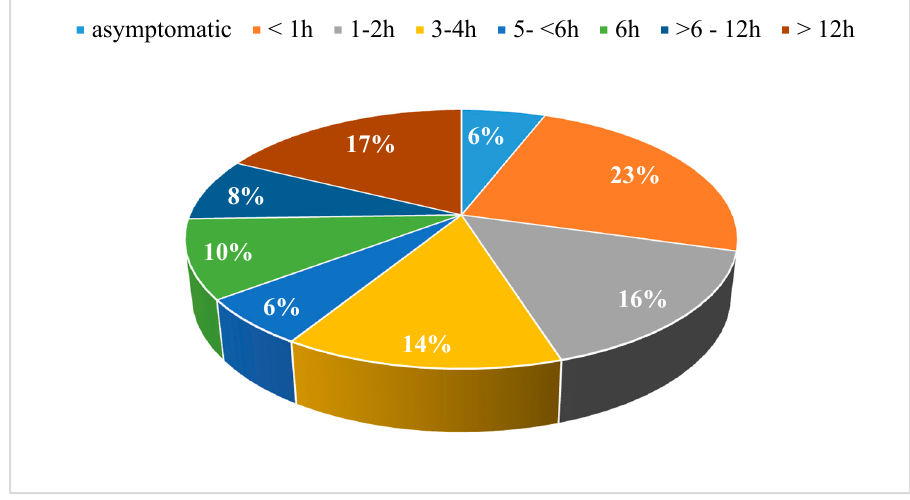
Figure 3. Latency from ingestion to onset of symptoms.